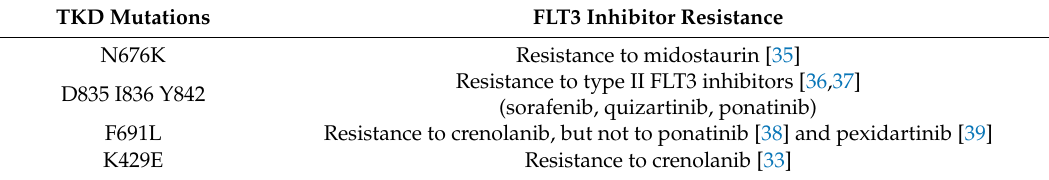
Table 2. FLT3 -TKD mutations conferring clinical resistance to FLT3